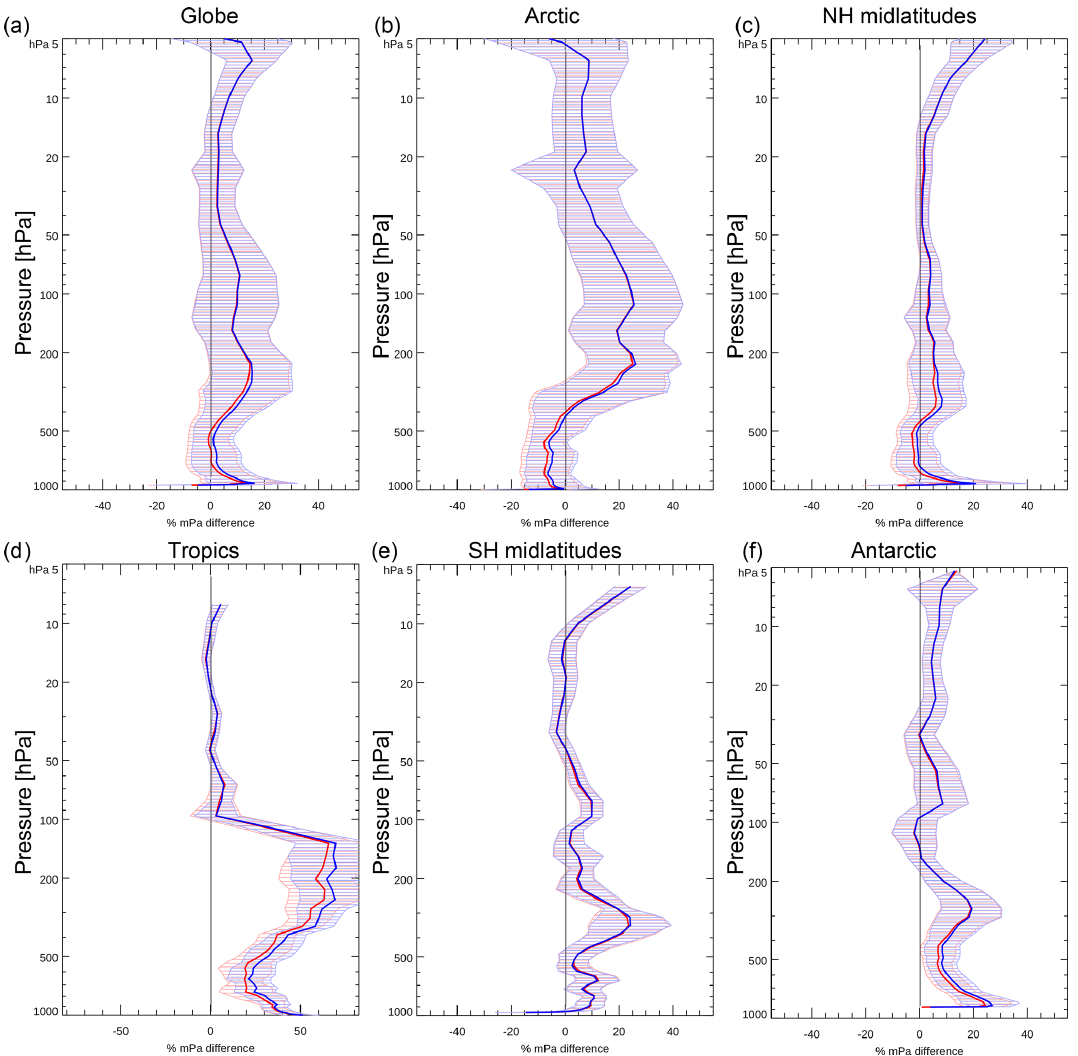
Figure 13. Mean relative O 3 bias for SON 2018 in percent between ASSIM (red) and CTRL (blue) and ozone sondes averaged over the (a) globe, (b) Arctic, (c) NH midlatitudes, (d) tropics, (e) SH midlatitudes and (f)